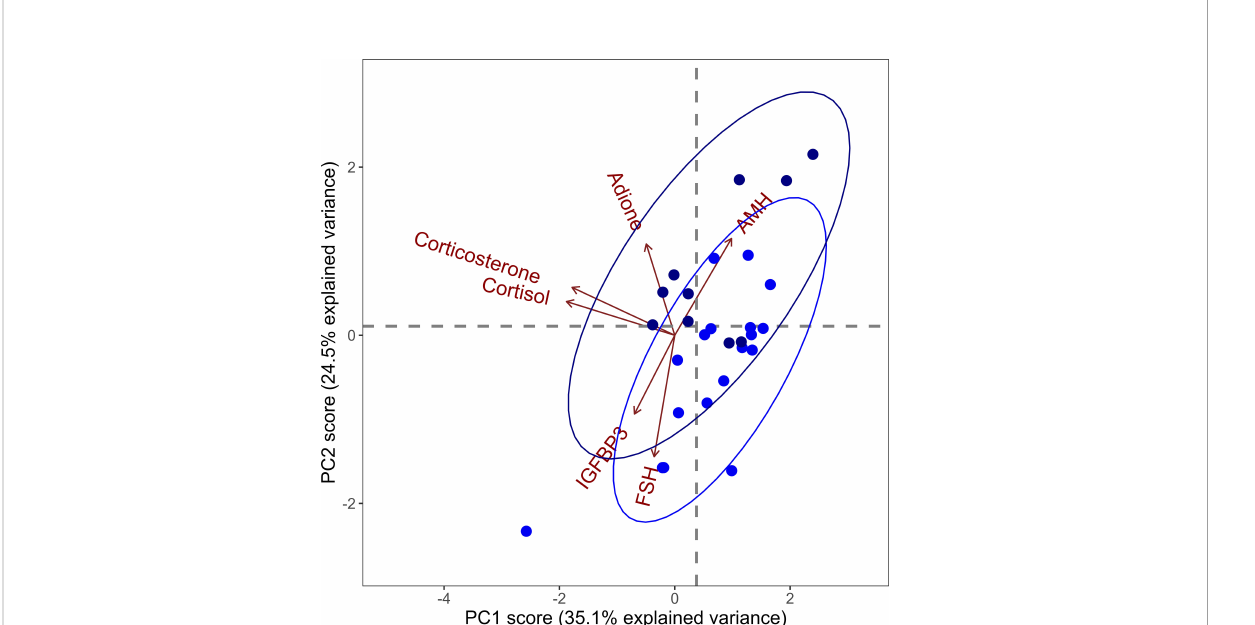
FIGURE 3 Principal component (PC) biplot for PC1 and PC2 based on hormone concentrations of anti-Müllerian hormone (AMH), adione (androstenedione), corticosterone, cortisol, insulin-like growth factor-binding protein-3 (IGFBP3) and follicle-stimulating hormone (FSH) in boys at the fi rst visit (median age 11 days). These two principal components account for a total of 59.6% of the dataset variance. Arrows (i.e. vectors) represent the correlation coef fi cients of the hormones with the principal components, and these should be interpreted horizontally for PC1 and vertically for PC2. While cortisol and corticosterone were almost aligned in the horizontal plane, indicating a strong correlation with PC1, adione was almost aligned vertically, indicating a strong correlation with PC2. Darker blue dots represent boys with persistent breast tissue, while lighter blue dots represent boys with